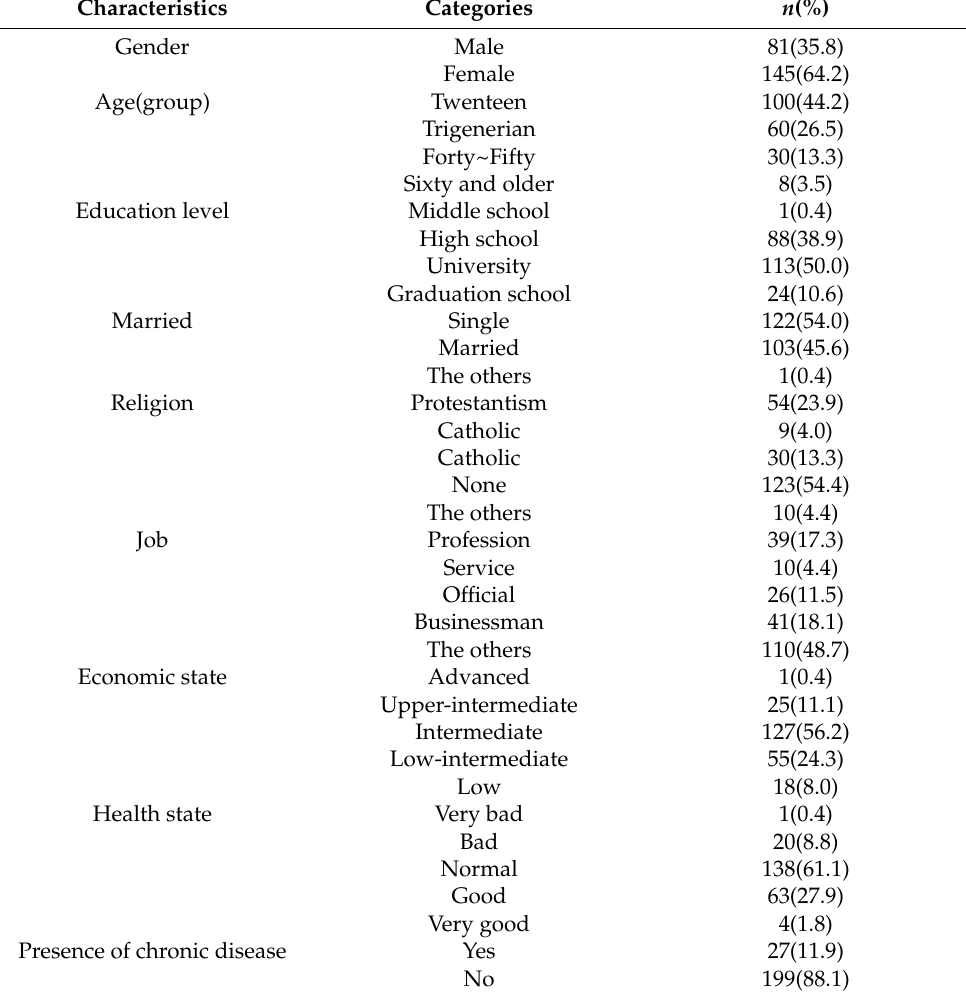
Table 1. General Characteristics ( N =